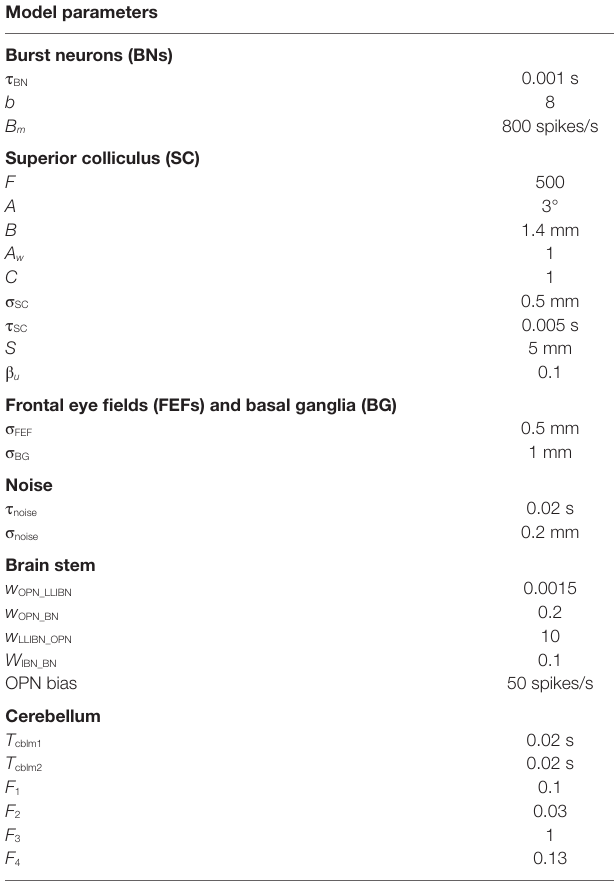
TaBle 1 | Model parameters.